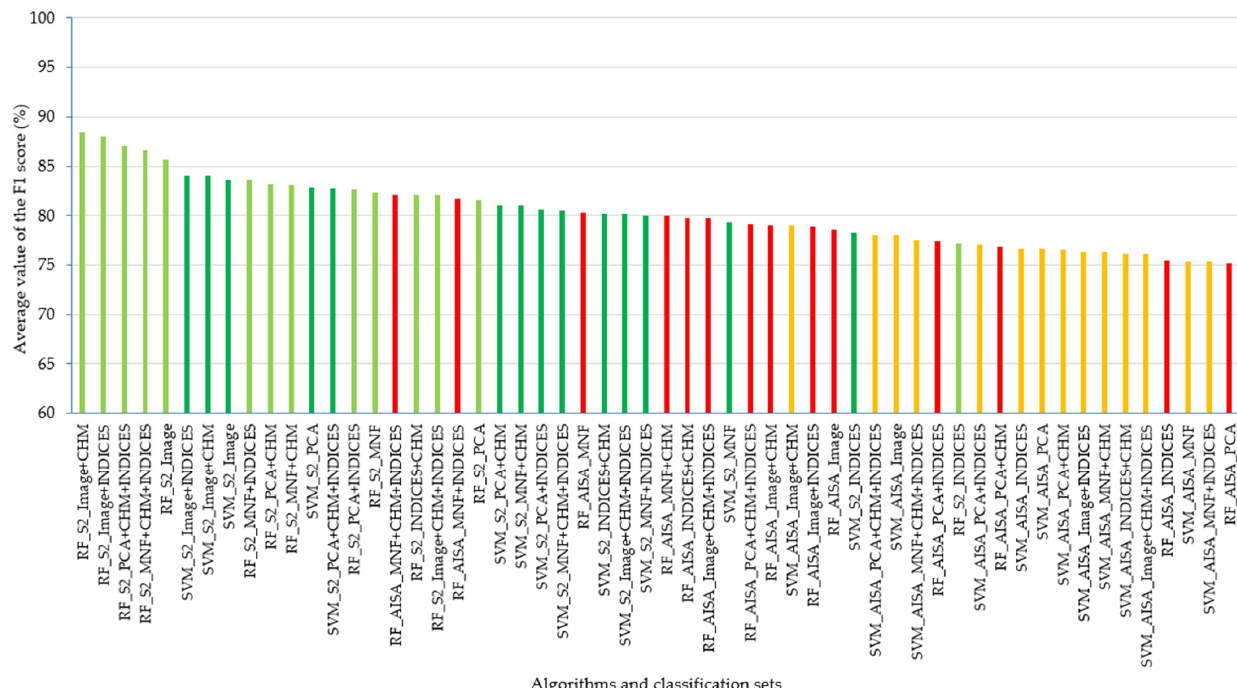
Figure 4. The best classification results achieved from analyzed scenarios and classifiers: orange boxes mean SVM of AISA images, red—RF of AISA images, dark green—SVM of Sentinel ‐ 2, light green—RF of Sentinel ‐ 2 images.